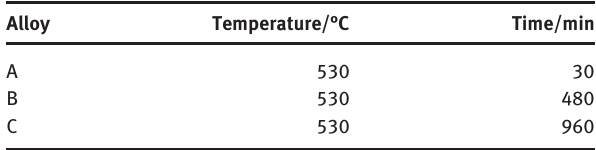
Table 2: Parameters of solid solution treatment for alloy